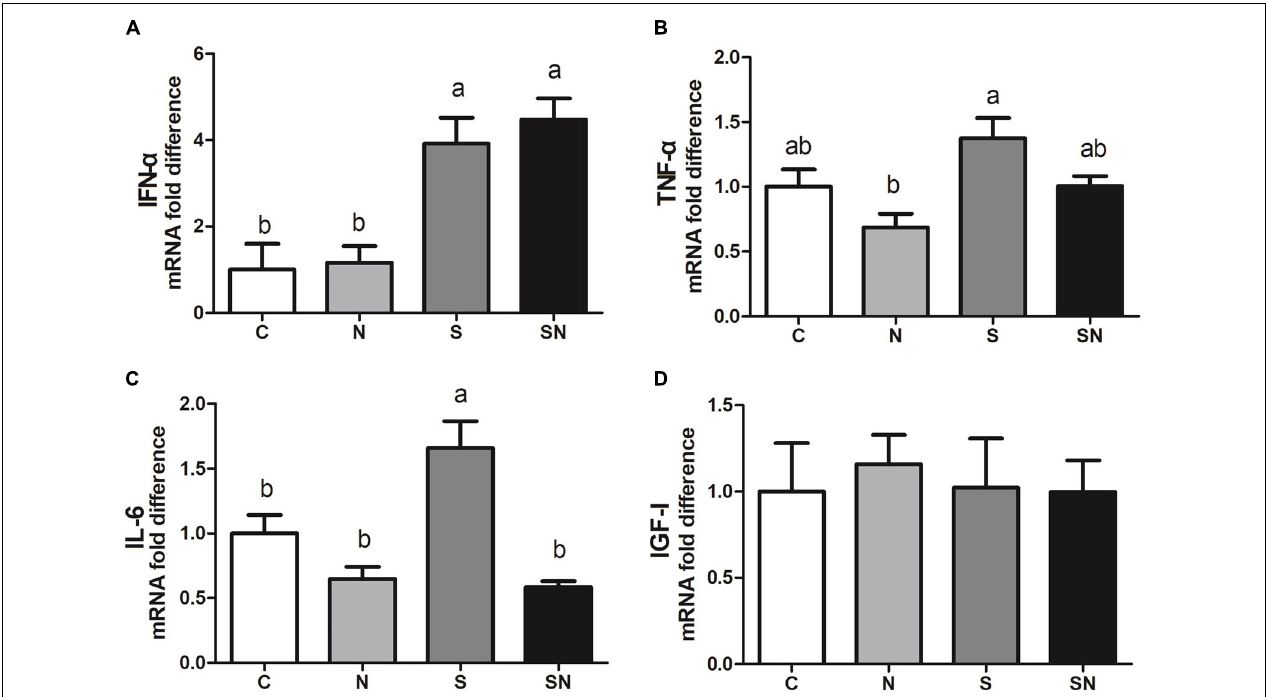
FIGURE 7 | Effect of Fe 3 O 4 -NPs on IFN- α (A) , TNF- α (B) , IL-6 (C) and IGF-I (D) mRNA expression in the livers of chickens exposed to Fe 3 O 4 -NPs in the absence or presence of S . Enteritidis administration. Values represent the mean ± SEM. Different letters indicate statistically significant